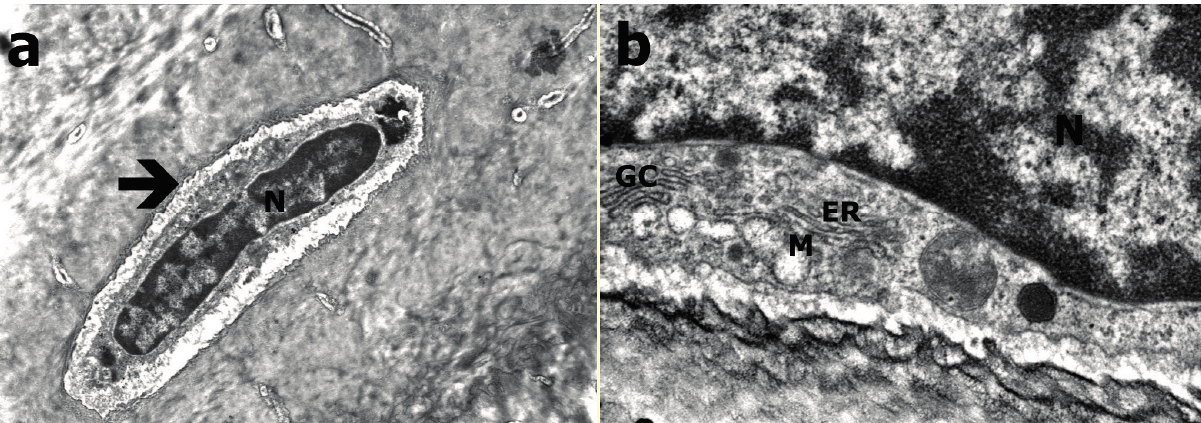
Figure 3. TEM evaluation of Group C; ( a ) Osteocyte within lacunae (black arrow) and cytoplasmic extensions (black and white arrow), N refers to nucleus (at 15K×); ( b ) Osteocyte (black arrow), M refers to mitochondria (at 135K×).